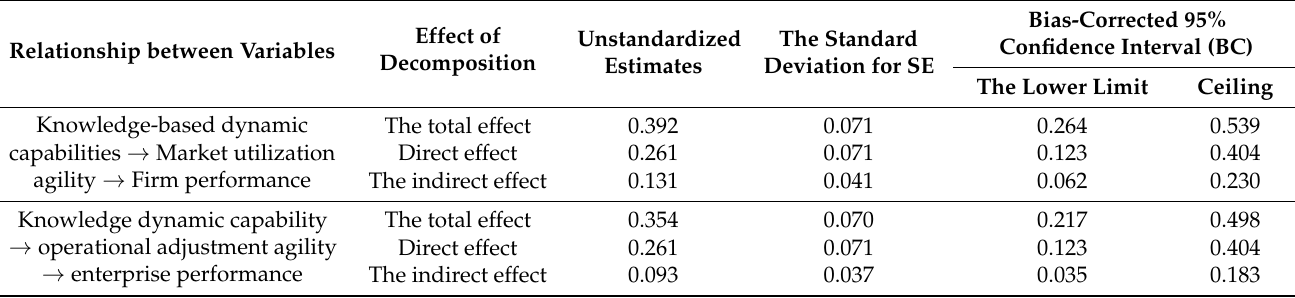
Table 5. Mediating Effect Test Table (N = 229).